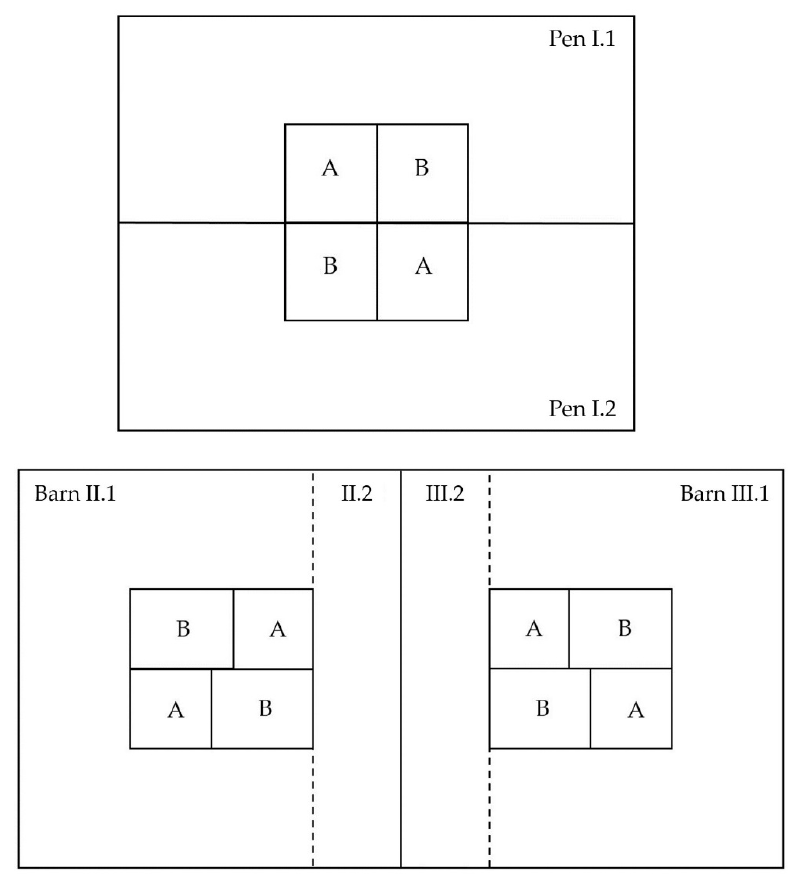
Figure 2. Above: Outline of Barn I with its two pens (I.1 and I.2) and two feeding areas (A and B) per pen. Below: Outline of barn II and III, each subdivided in a bigger (II.1; III.1) and a smaller (II.2; III.2) area and four feeding areas (A and B) per barn.